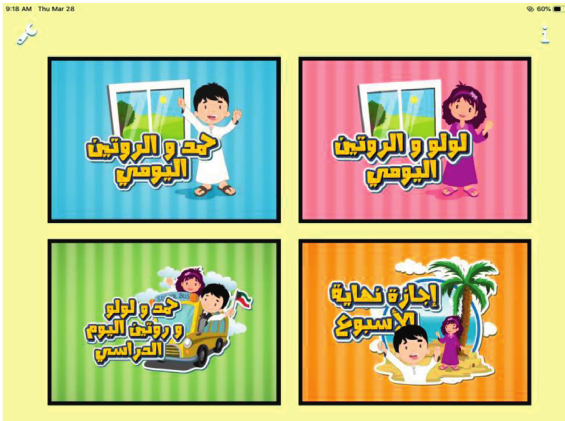
Figure 1: eStories.